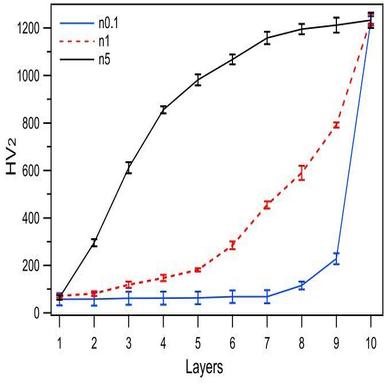
Change the hardness of layer for FGM samples depending on the compositional gradient.